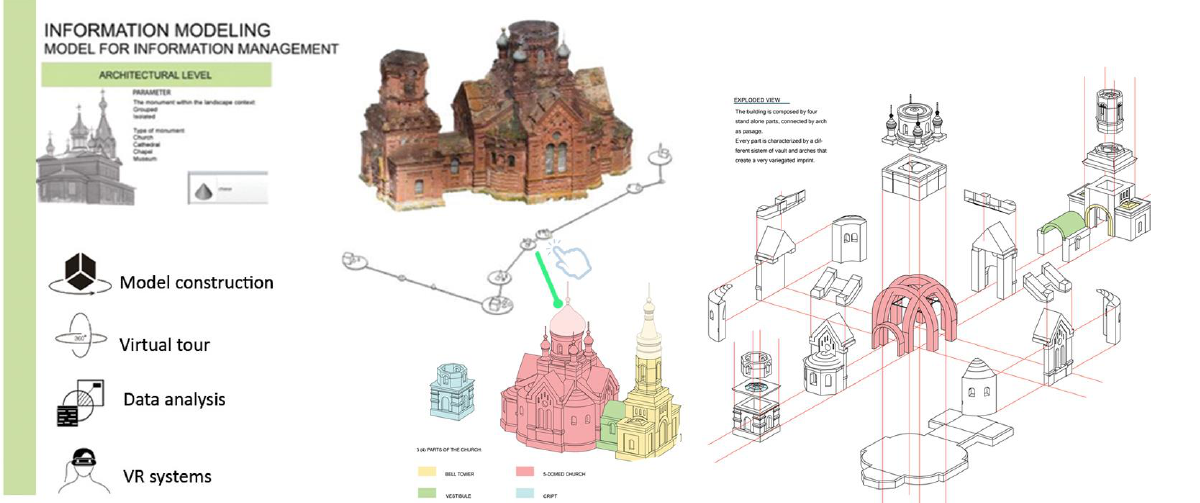
Figure 8. Complexity of parameters and links between information system and architectural complexity. The different levels of graphic interaction and implementation conduct to deeper levels of knowledge and morphological detail of